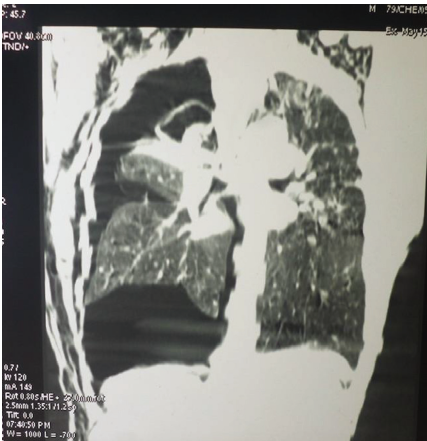
Figure 2: Chest CT scan frontal view. The aspergilloma is seen in the apical region. There is extensive subcutaneous emphysema bilaterally. The upper lobe is totally destroyed, the middle lobe is fibrotic, and the lower lobe is atelectatic and retracted. There are massive pneumothorax, bilateral fibrosis, and sequelae of tuber- culosis mainly at the left